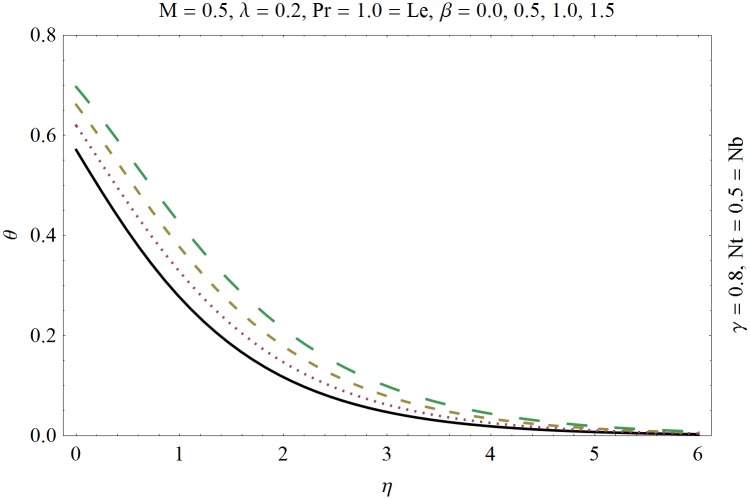
Influence of Deborah number β on θ.